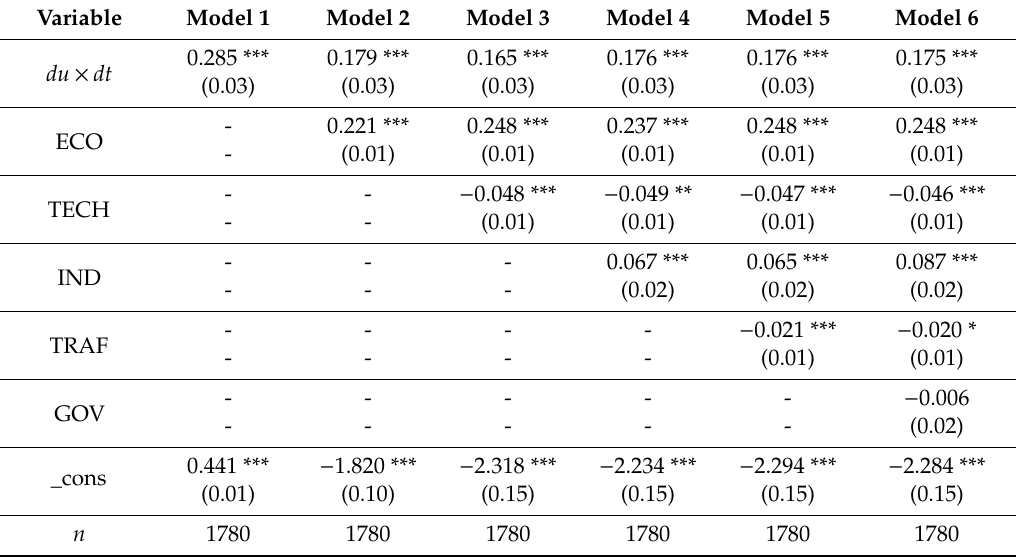
Table 2. Regression results for the impact of smart city policies on green total factor productivity (GTFP).